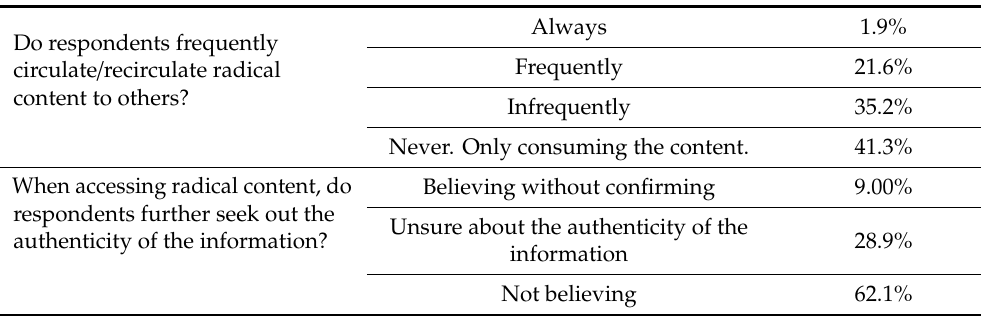
Table 2. Involvement in Circulating Radical